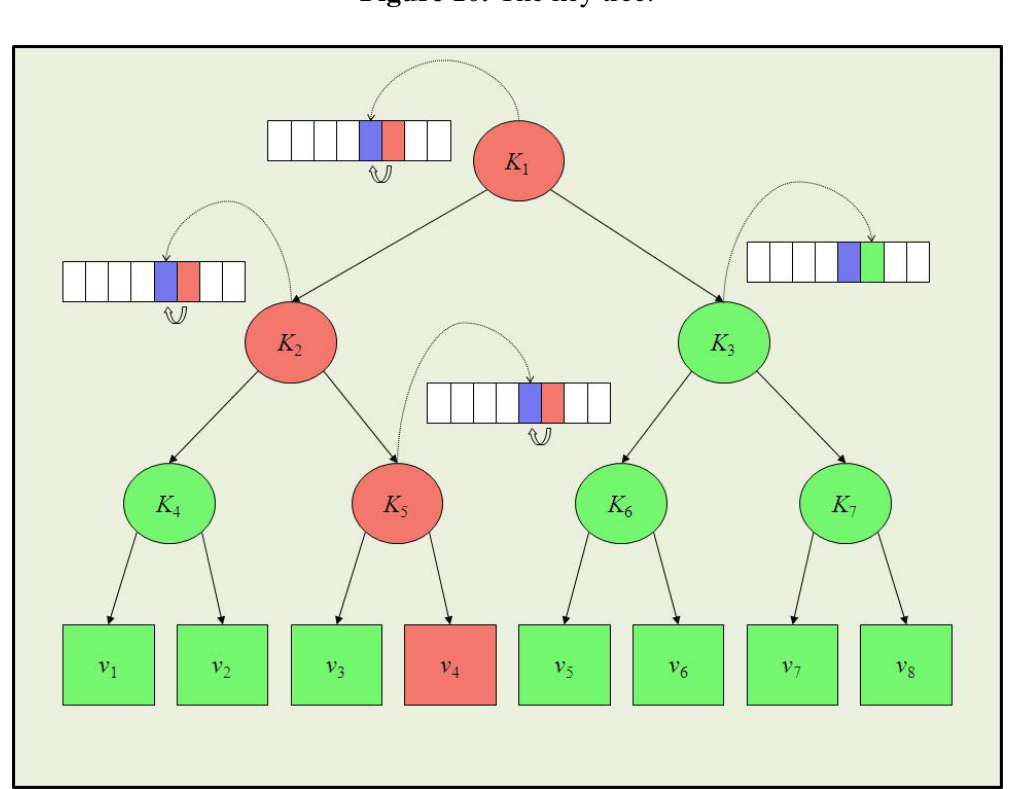
Figure 10. The key